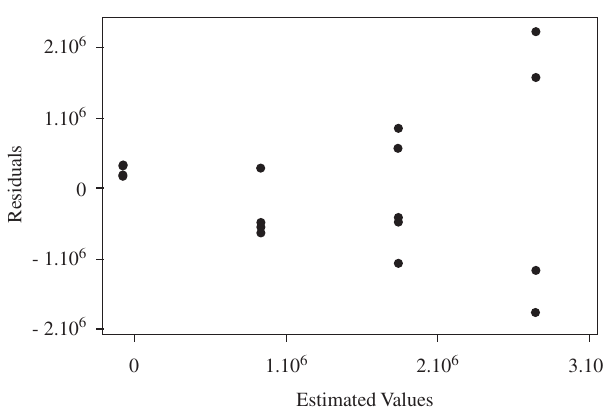
Figure 6. Graph of residuals against estimated values for rolled notch tes- tpieces.